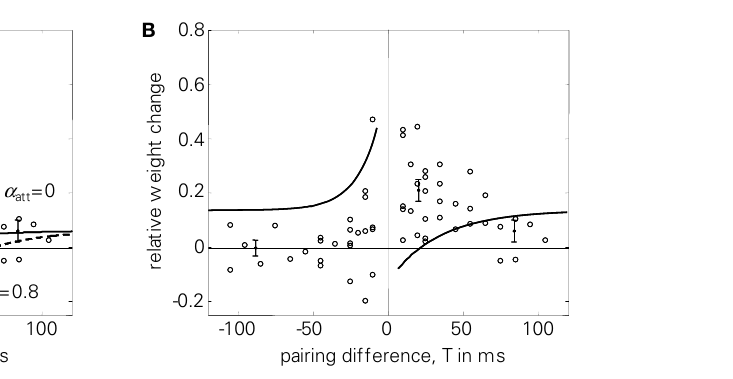
FigurE 8 | Quadruplet protocol (4). Single data points in the diagrams extracted from Wang et al. (2005), points with error measures as given in Pfister and Gerstner (2006), based also on Wang et al. (2005). (A) LCP with SRM with